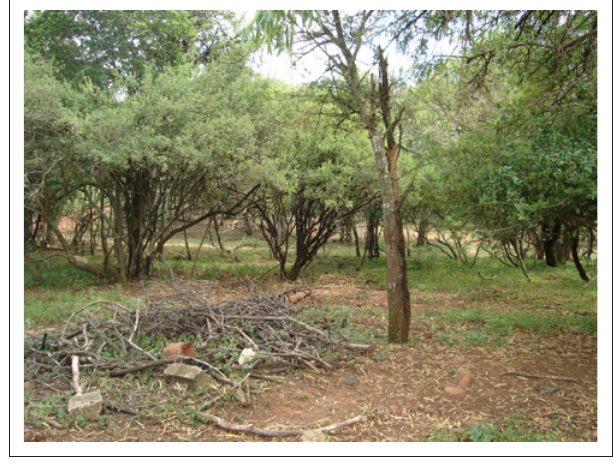
FIGURE 1: The clearly visible browse line in the pasture.